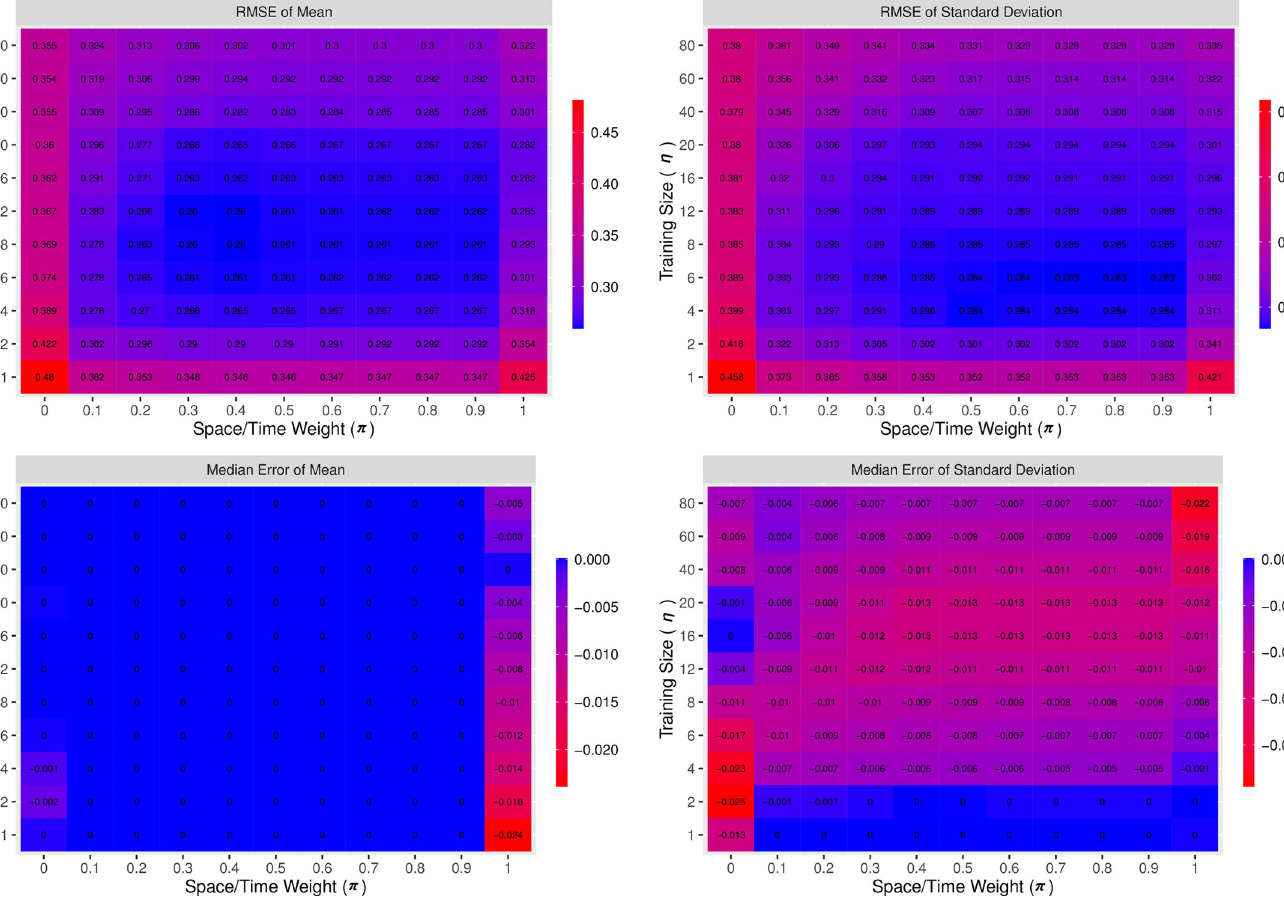
Fig 3. Hyper-parameter grid search predictive validity. Predictive validity metrics for the mean and standard deviation of attainment predictions of space-time distance model, over the grid of hyper-parameters tested using out-of-sample predictive validity. The grid search was remarkably planar in the middle of the search space, as the model does not seem to be that sensitive to hyper-parameter selection. The best hyper-parameter set with respect to RMSE in average attainment is a π of .6 and an η of 12, which was chosen at the hyper-parameter set to split the binned